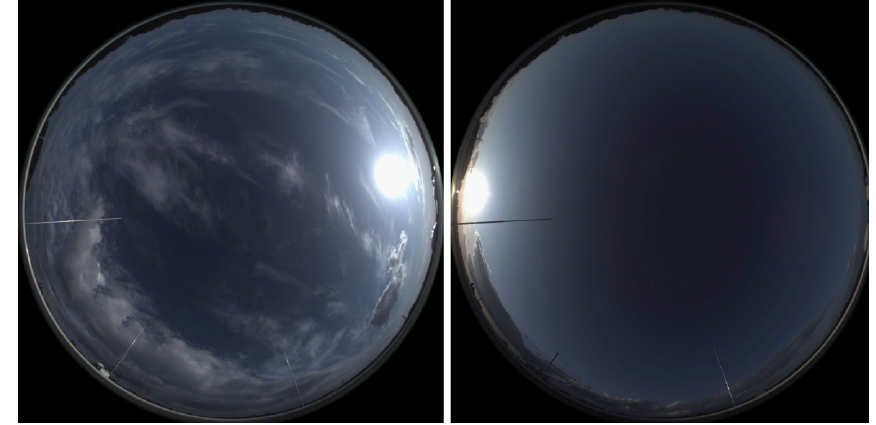
Figure 7. Sky images taken by ASI UOL, representing a multi-cloud-layer situation on 2 September 2019 07:20 (left) and an almost-clear-sky situation on 2 September 2019 17:00 (right),